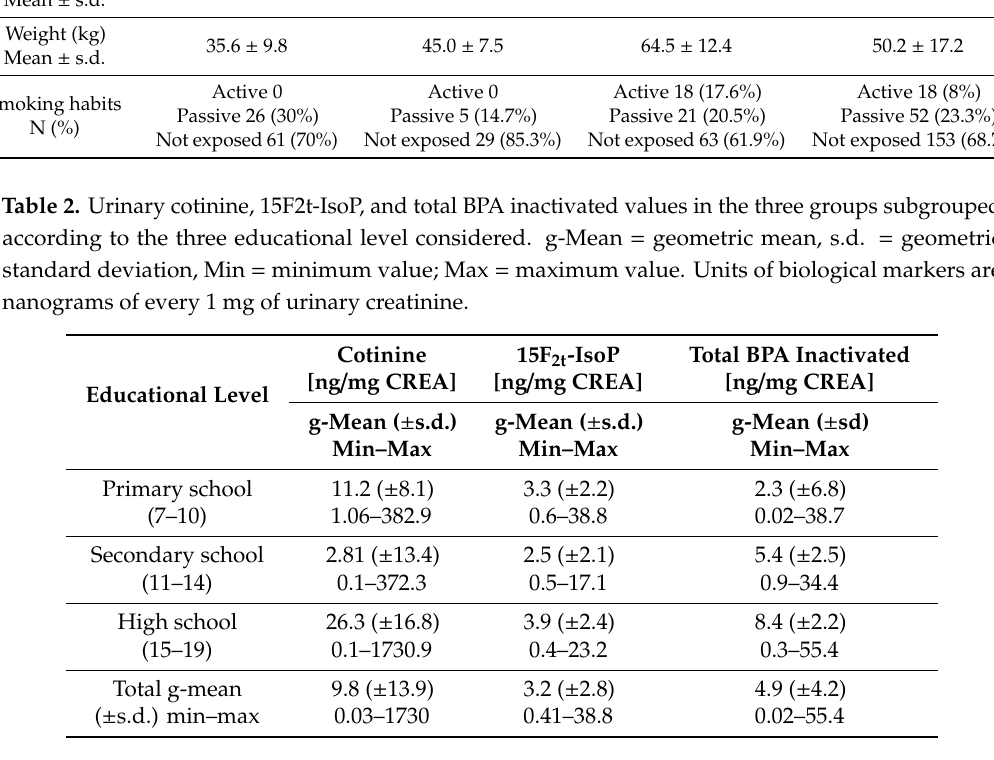
Age (years) Mean ± s.d.